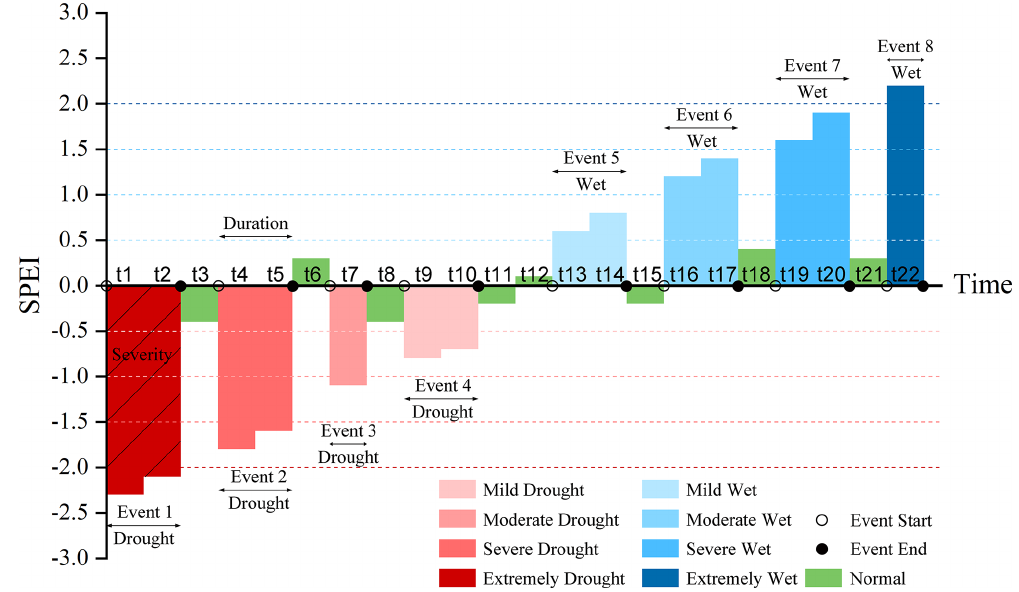
Figure 2. Schematic diagram of drought and wet events (the red shaded area denotes the drought events; the blue shaded area denotes the wet events).